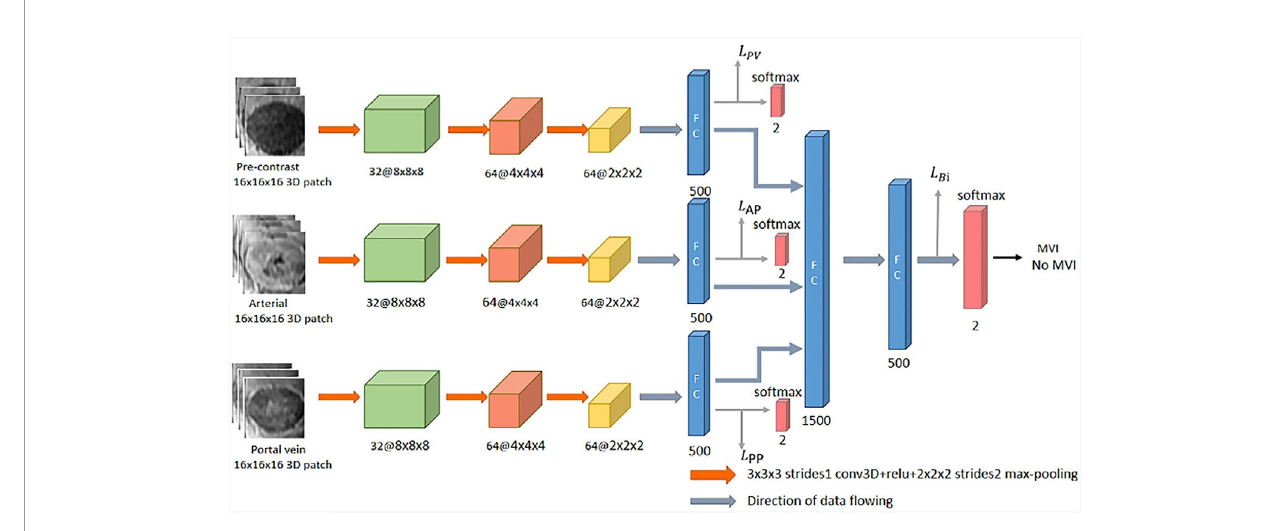
FIGURE 2 | The fl owchart of the proposed deep learning